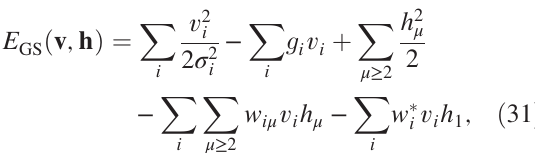
. The changes on log-likelihoods are disent